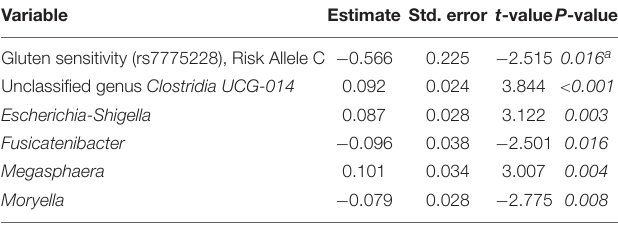
TABLE 6 | Reduction in IBS symptom severity linear model: demographics + genomics + microbiome (D + G + M). Variable